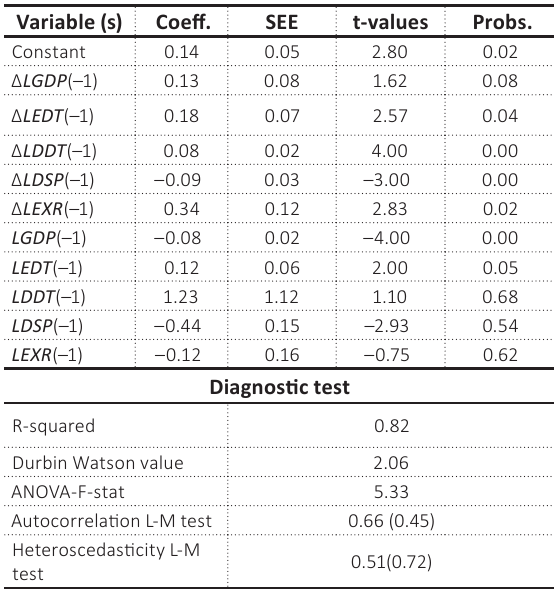
Table 3. ARDL model estimation (dependent